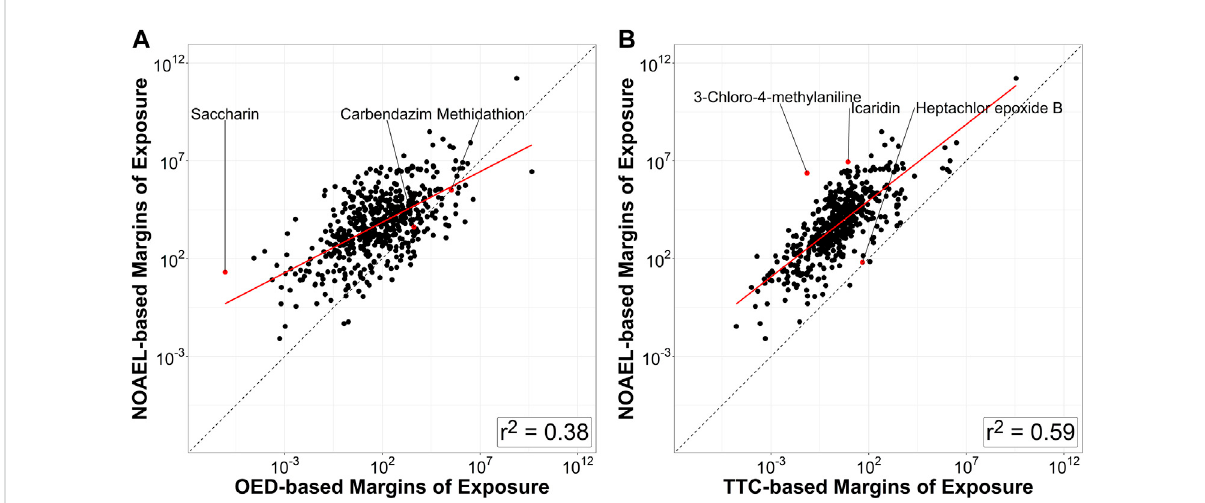
FIGURE 5 Relationship between various margins of exposure based on various estimates of chemical hazard for the 522 compounds that have all three values(NOAEL,OED,andTTC). (A) Marginsofexposure derivedfrom invivo NOAELvaluesarecomparedtomarginsofexposurederivedfromOEDs basedonToxCast.Greydashedlinerepresentsequivalencebetweenthetwometrics. (B) Marginsofexposurederivedfrom invivo NOAELvaluesare compared toTTCs.Forthisanalysisthe fi lterforGenotoxicity wasnotapplied indeterminingtheTTCvalue,because theOEDsandNOAELsare basedonnon-cancerendpoints.Allbuttwocompounds(per fl uorooctanesulfonicacidandper fl uorononanoicacid)haveaNOAEL-basedmarginof exposure that is higher than the TTC-based margin of exposure. Coef fi cient of determination between log 10 -transformed NOAEL-based MoE and OED-basedMoEforthesecompoundsis( r 2 =0.38),whereascoef fi cientofdetermination betweenlog 10 -transformedNOAEL-basedMoEandTTC- based MoE is ( r 2 = 0.59). Labeled points provide examples of the chemicals with the most divergent (saccharin, 3-chloro-4-methylaniline,